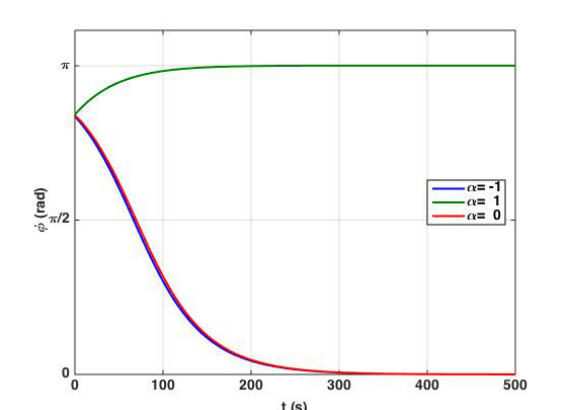
Figure 3. The solutions of φ for different values of the bifurcation parameter α . For the two cases of α < 0 (damped) and α = 0 (critical) the two oscillators become in-phase with the relative phase of φ = 0. Obviously, the rate of change of φ for the damped oscillation is greater than the critical one. When α > 0 (spontaneous), the two oscillators become anti-phase. In this figure a = α + 1, b = c = ω = 10, d = a − 2, (cid:101) = 0.1, c 1 = c 2 = c 3 = c 4 = (cid:101) , β = A 21 and δ = 0.1. The initial conditions were r 1 = r 2 = 1, φ 1 = π and φ 2 = π